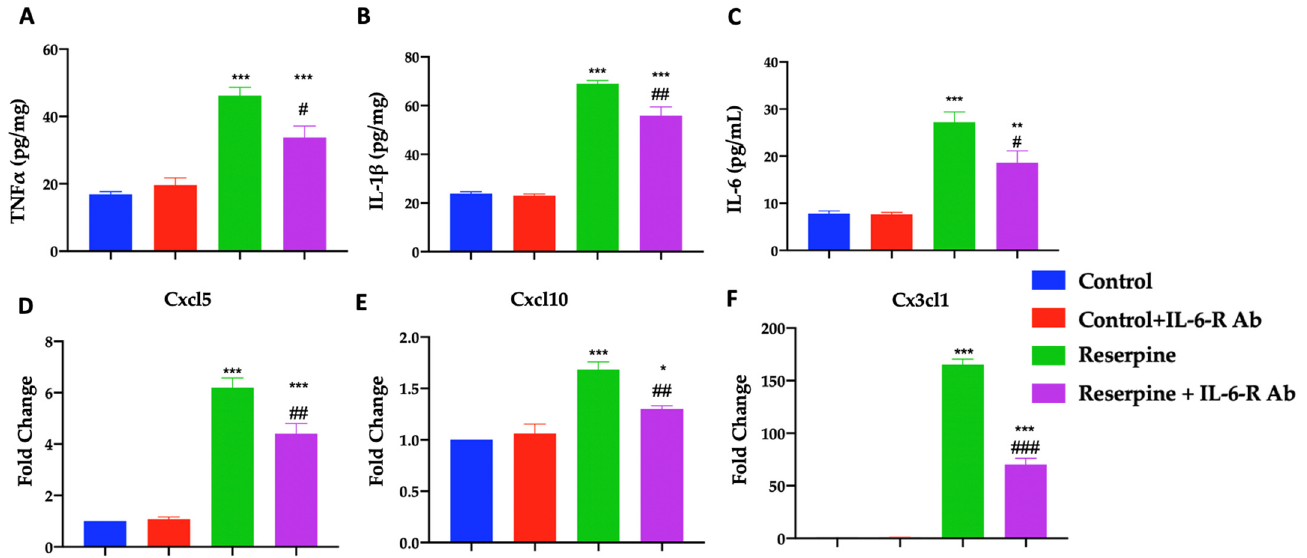
Figure 4. Effects of IL-6-R Ab on pro-inflammatory mediators: ELISA analysis of: ( A ) TNF- α , ( B ) IL- 1 β and ( C ) IL-6 expressions; RT-PCR analysis of: ( D ) Cxcl5, ( E ) Cxcl10 and ( F ) Cx3cl1 expression.